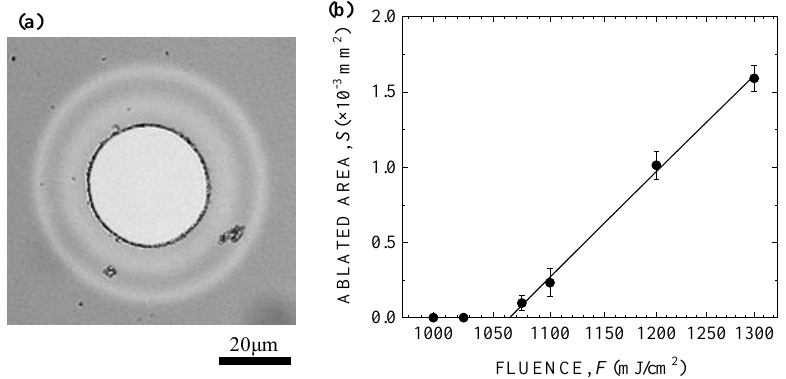
Figure 3. ( a ) Optical microscope image of the silicon suboxide film irradiated with a single fs pulse at F = 1200 mJ/cm 2 , and ( b ) single-shot fs laser ablated area S plotted as a function of the laser fluence F .